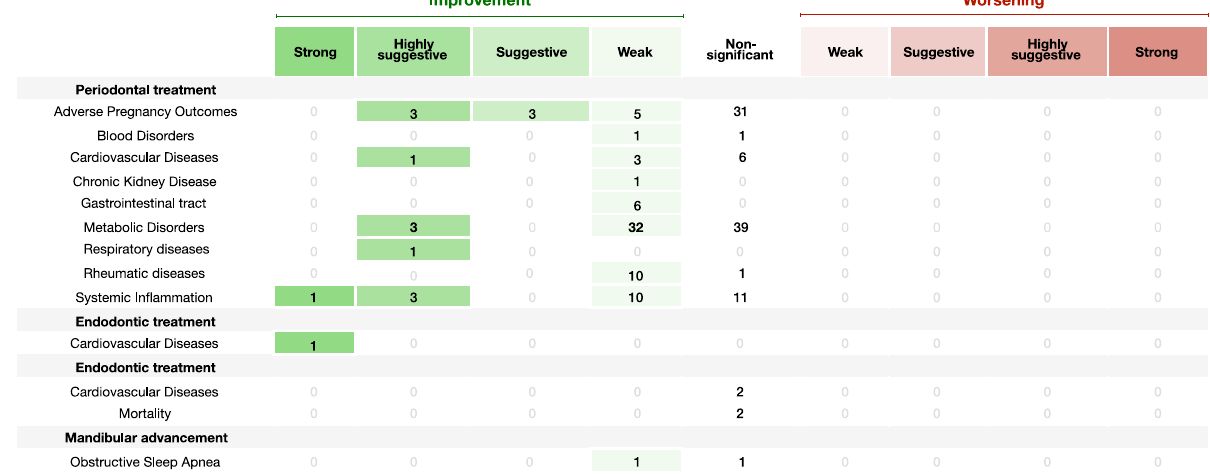
whereas the left side shows associations that reduce the risk (in green). APO adverse pregnancy outcomes, CVDs cardiovascular diseases, CKD chronic kidney disease. Source data are provided as a Source Data fi